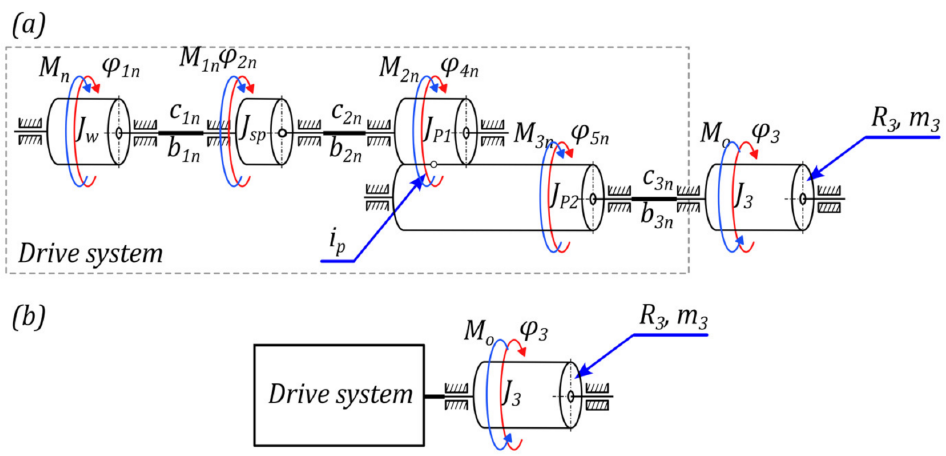
Figure 2. Simplified drive system: ( a ) base model and ( b ) simplified